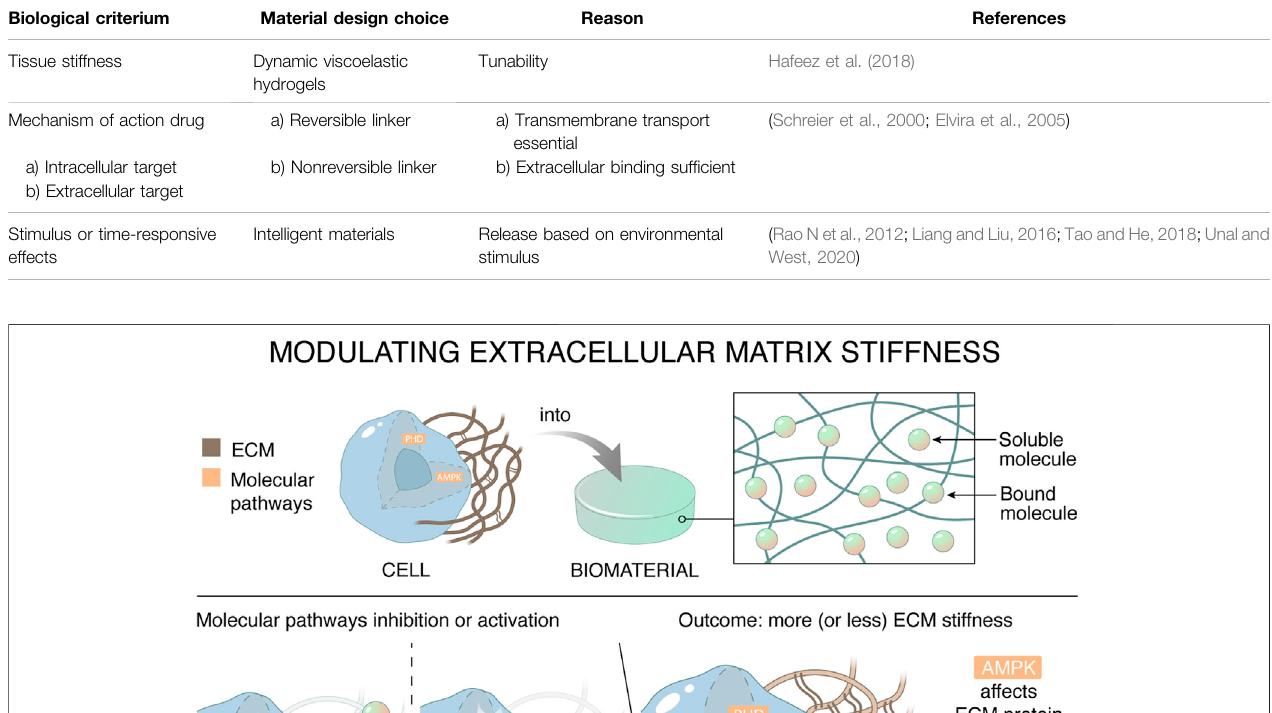
TABLE 3 | Design criteria for synthetic materials that affect the extracellular matrix via cellular metabolism. Biological criterium